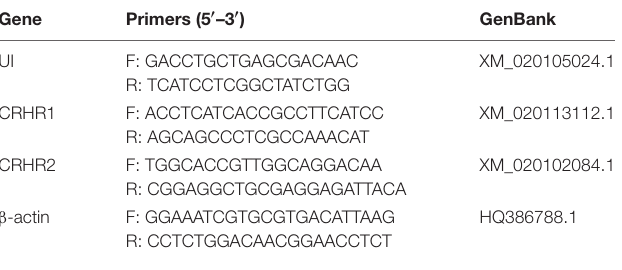
TABLE 1 | Primer sequences used for real-time PCR